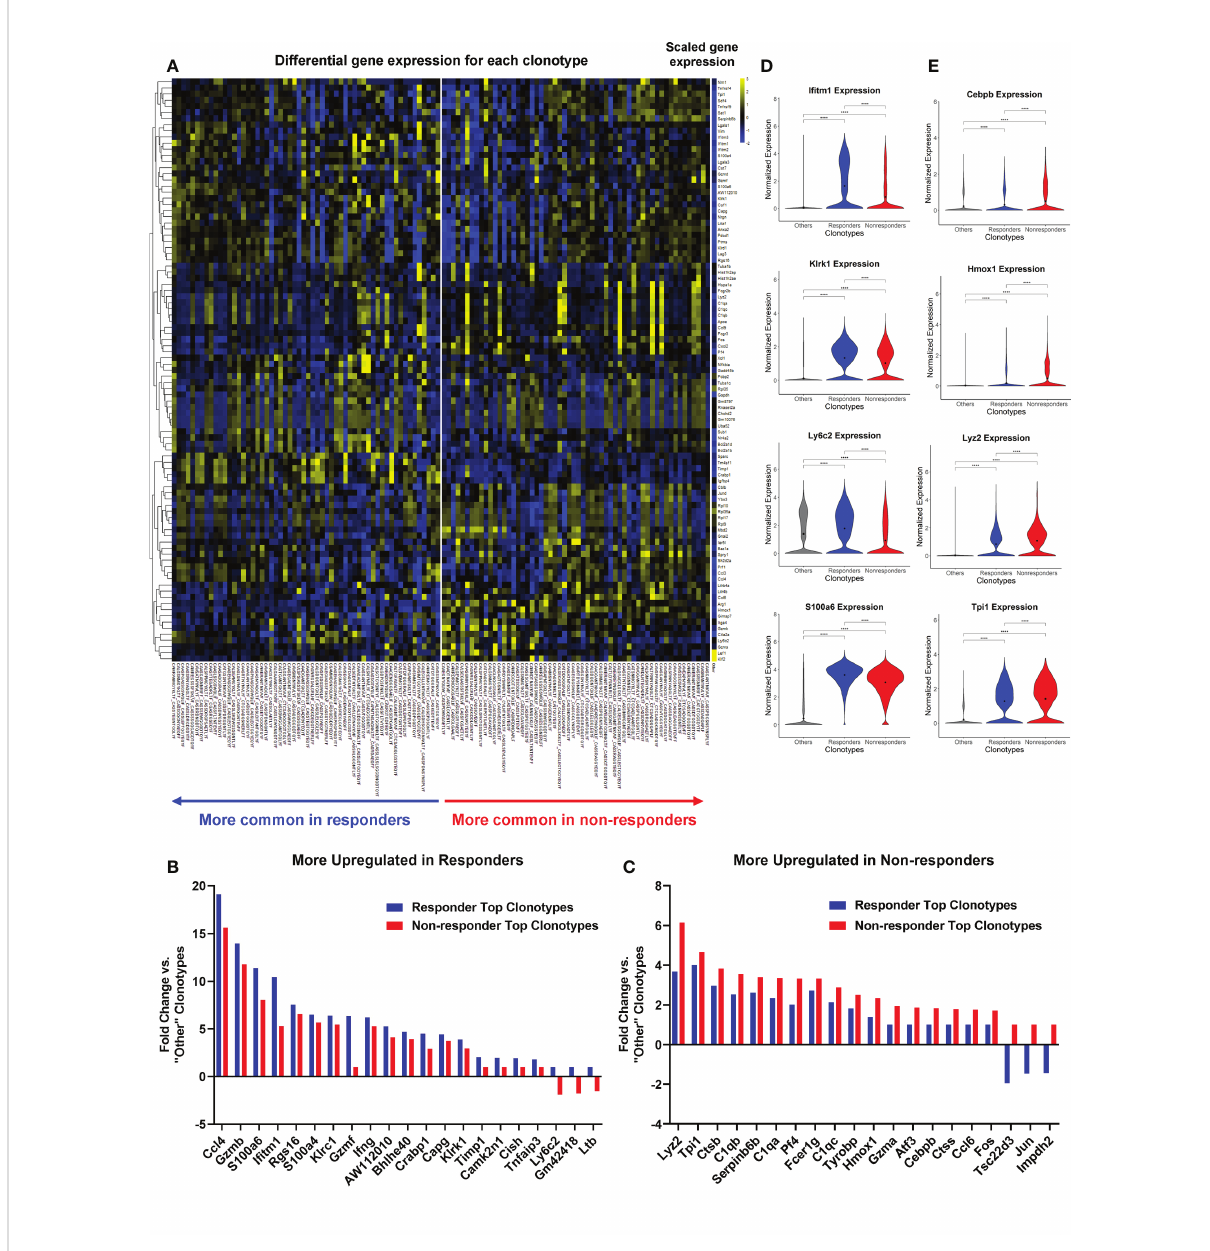
FIGURE 6 Top TCR clonotypes of TILs exhibited differentially activated genes in responders (R) vs . non-responders (NR). All cells from top TCR clonotypes (>0.65% in R TIL and >1% in NR TIL, n=58 per group) were compared against all cells with clonotypes <1% of all spleen samples ( “ Other ” ) using Seurat ’ s FindMarkers function. (A) Heatmap showing the gene expression where values are the average of scaled expression for all cells with a given clonotype. Genes were fi ltered for those differentially expressed in R and NR clonotypes ( ≥ 0.4 difference between R fold change and NR fold change). Color intensity is scaled by row. (B, C) Fold changes of representative genes more upregulated in R (B) or NR top clonotypes (C) vs . “ Other ” clonotypes ( ≥ 0.6 difference between R fold change and NR fold change). See Supplemental Table 6 for the list of genes with fold changes and P -value. (D, E) Violin plots showing the expression of representative genes upregulated in R (D) or NR (E) top clonotypes compared to “ Other ” clonotypes. Black dot indicates the mean of each group. Different groups were compared using one-way ANOVA followed by Tukey ’ s multiple comparisons test (**** P